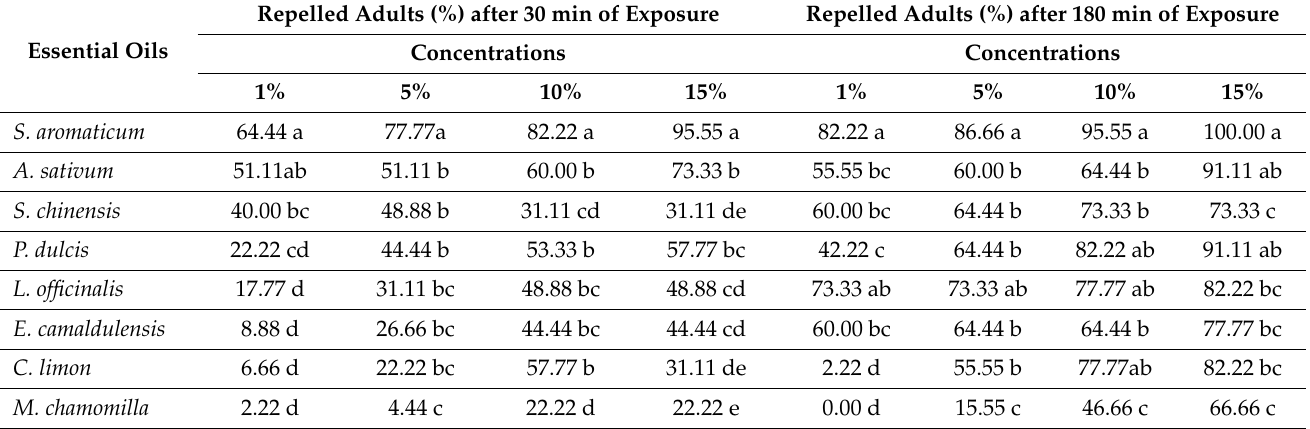
Table 1. Repellency impact of eight essential oils against T. castaneum after 30 and 180 min of exposure.